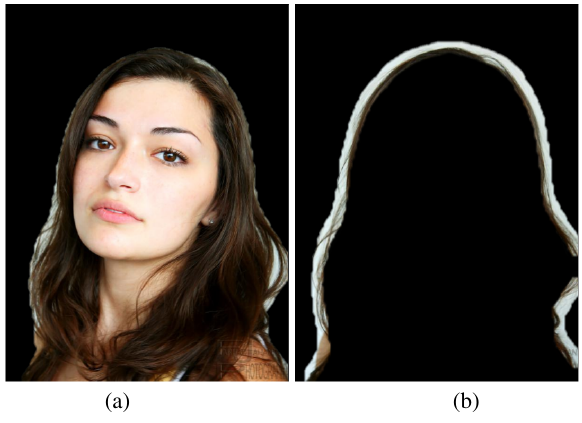
Figure 3. The result of morphology operations: (a) Segmentation result after CNN; (b) Border segmentation with morphology operations.